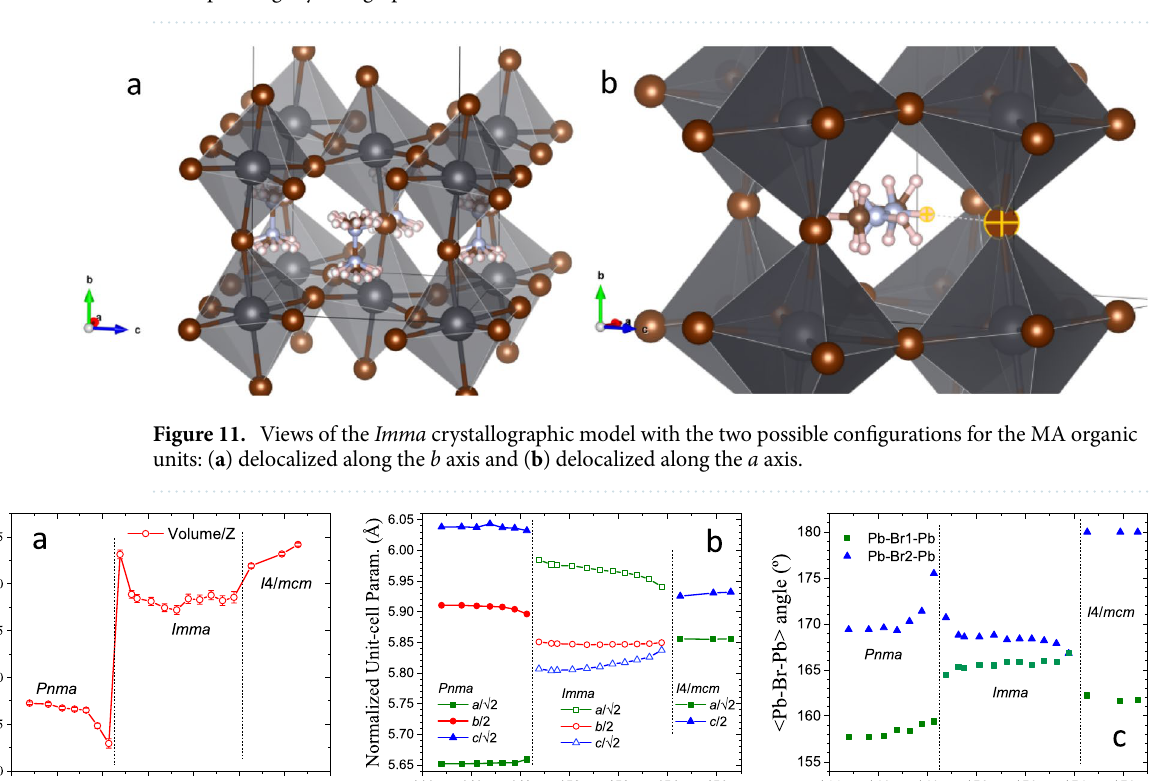
Figure 10. ( a ) Observed (crosses) calculated (black line) and difference (blue line) profiles after the Rietveld refinement from NPD data at 150.5 K, corresponding to orthorhombic ( Imma ) symmetry. ( b ) View of the corresponding crystallographic model.